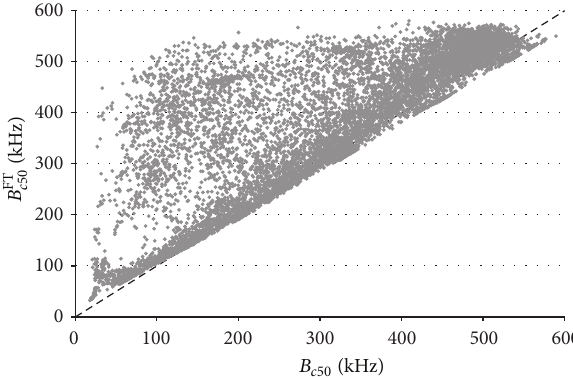
Figure 11: Relation between coherence bandwidth estimated from rms delay spread ( 𝐵 𝑐50 ) and from Fourier transform of power delay profile ( 𝐵 FT 𝑐50 ) for correlation level 0.5 in the Gdansk city